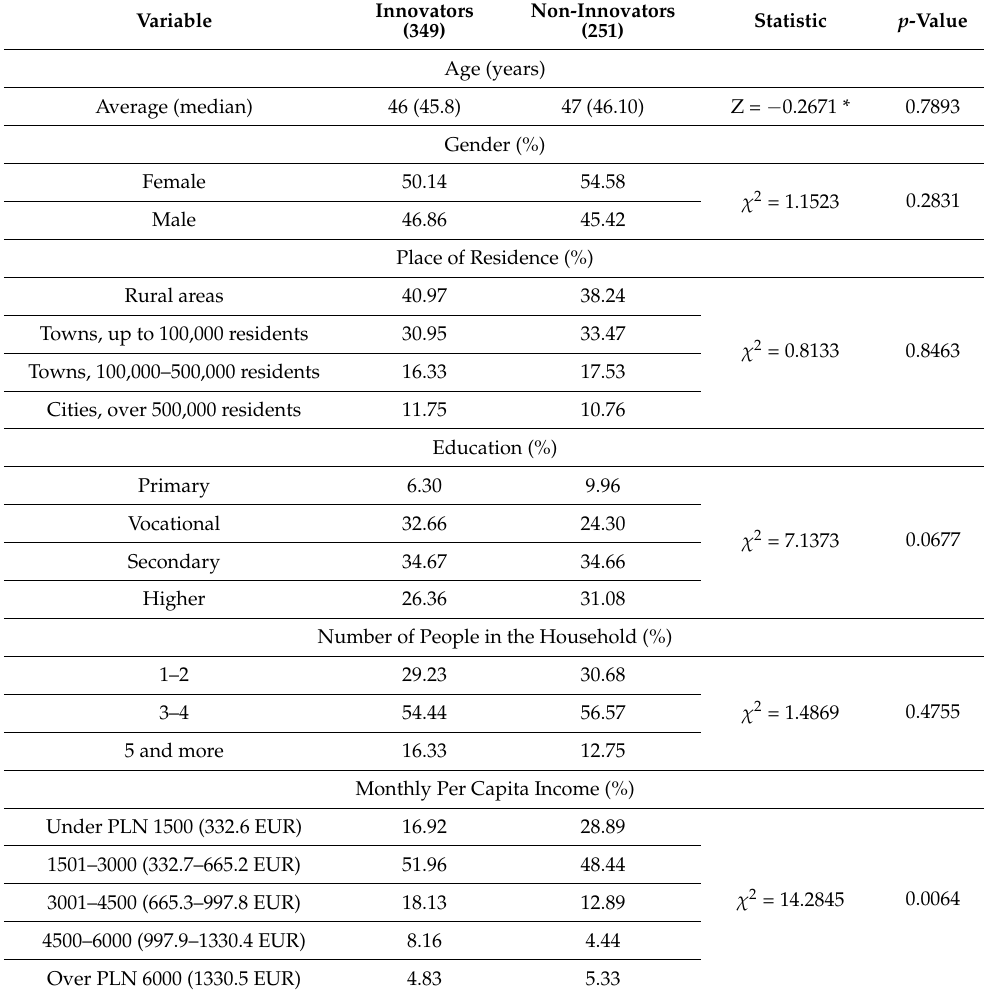
Table 2. Characteristics of innovators and non-innovators accounting for demographic, social and economic